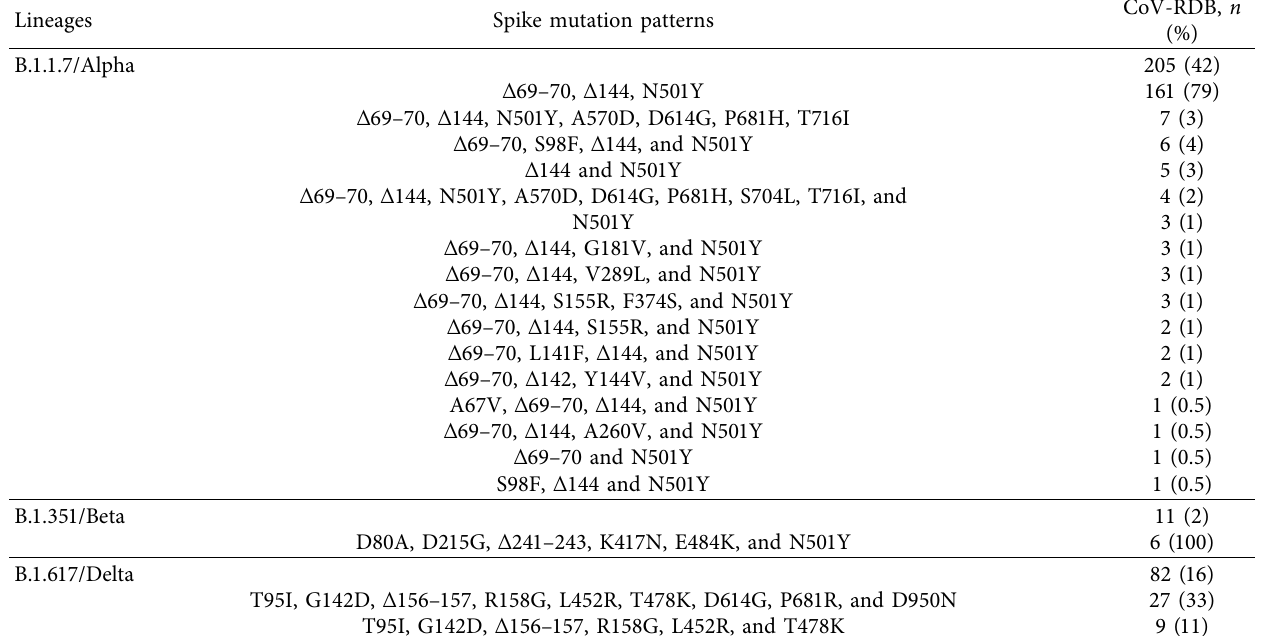
Table 1: Spike mutation pattern according to lineage and variants of SARS-CoV-2 strains circulating in